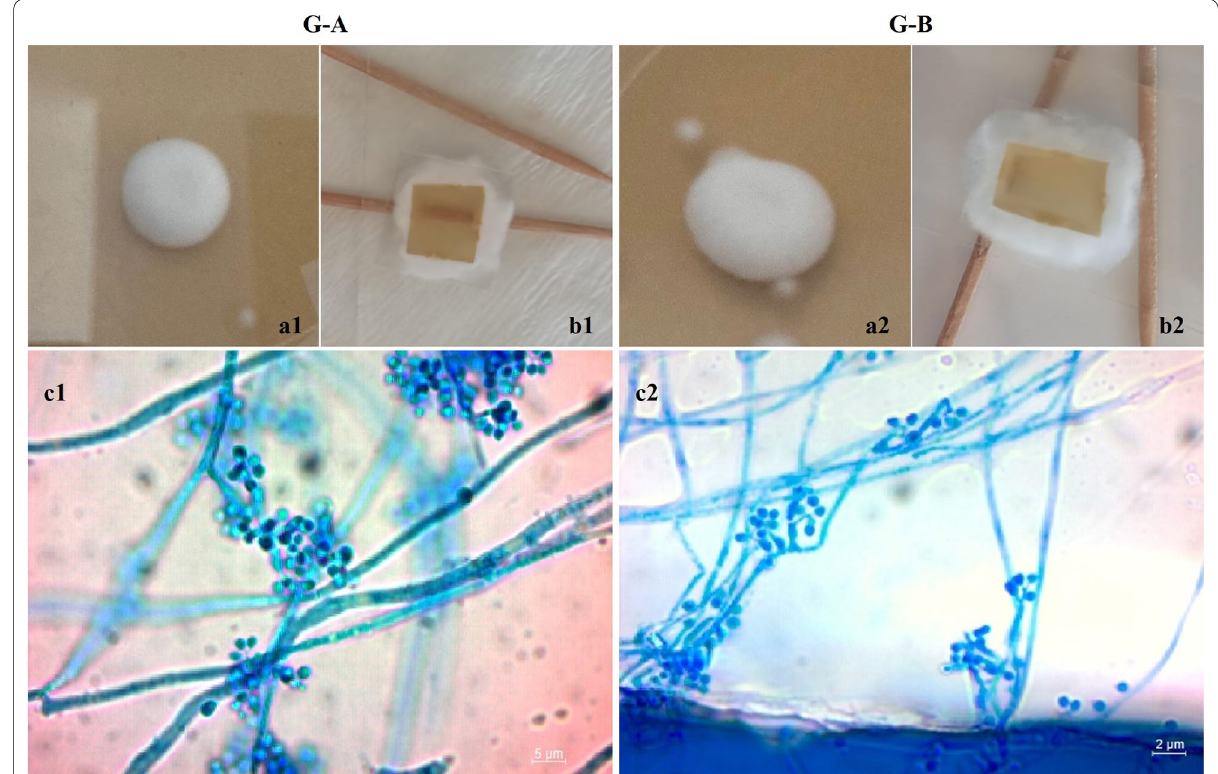
Fig. 1 Morphological observation of fungal isolates: a1 and a2 : colony morphology on Sabouraud CAF agar: b1 and b2 ; block cultures of fungal isolates: c1 and c2 , phase contrast microscopic image of the isolates (Magnification: 100X) (1 is the G -a isolate, 2 is the G-B